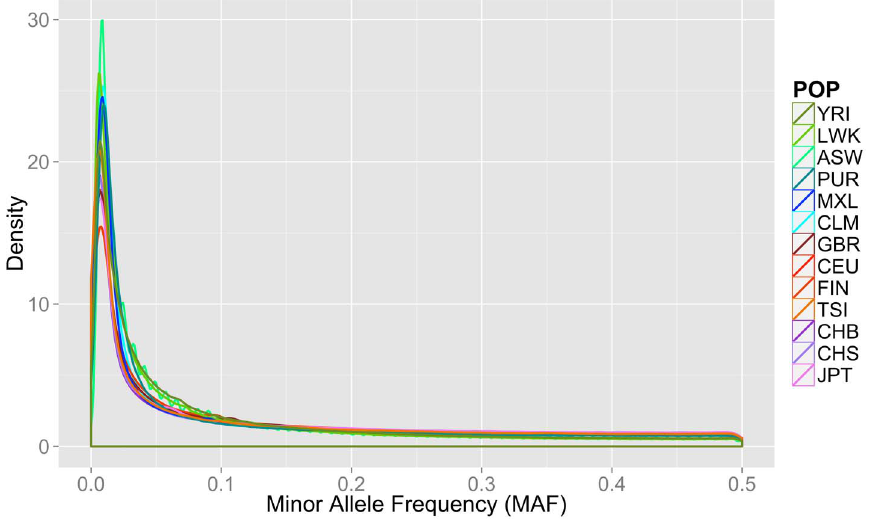
Figure 1. Minor allele frequency distribution on autosomal chromosomes for 13 1000 Genomes Project Phase I populations. Groups are color coordinated by continental ancestry: greens=African descent (YRI, LWK, ASW); blues=Mexican/Spanish descent (PUR, CLM, MXL); orange/ reds=European descent (GBR, FIN, CEU, TSI); and pink/purple colors=Asian descent (JPT, CHB, CHS). The populations of African descent have the highest proportion of low frequency